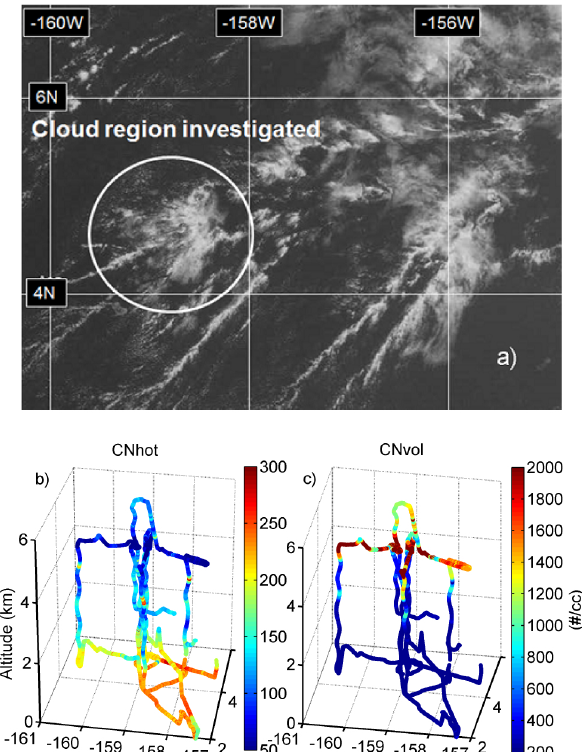
Fig. 3. GOES visible image (top) for 22:30UTC during RF04 cloud study (15 August 2007). Flight path plots (bottom) color coded with CNhot (left) and CNvol (right). Horizontal legs to west, south and east flown in outflow layers at 4.3km show marked depletions of CNhot and strong enhancement of CNvol relative to the